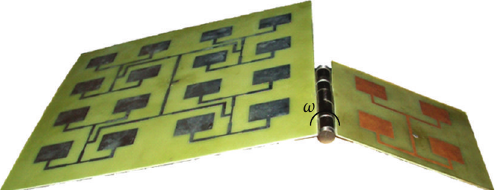
Figure 15: The investigated setup.